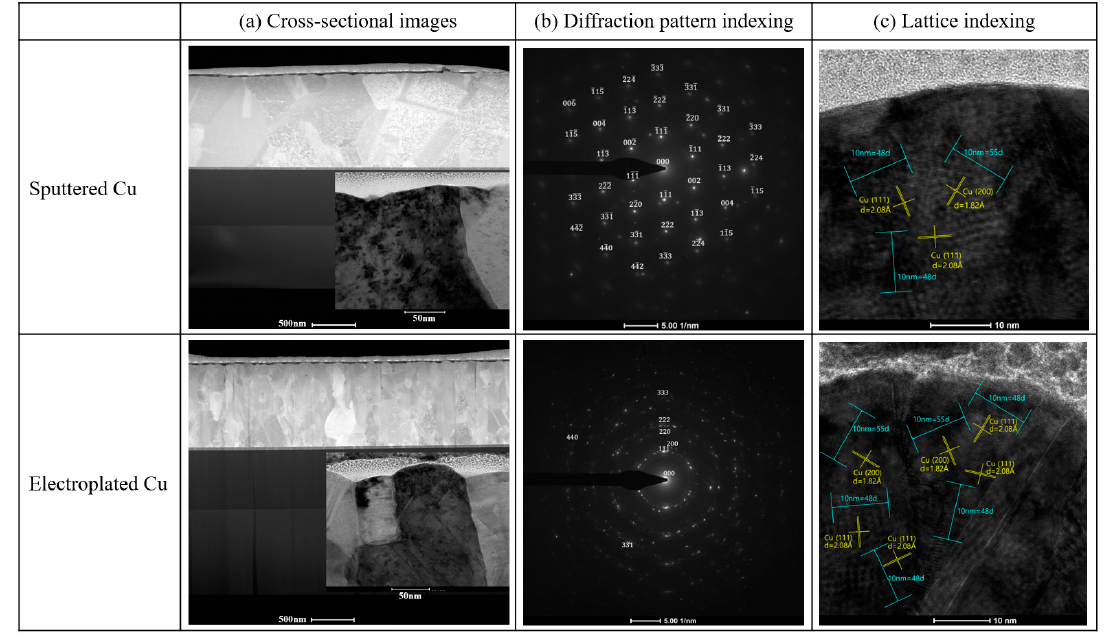
Figure 4. TEM analysis of plasma treated Cu thin films: ( a ) cross-sectional images, ( b ) diffraction pattern indexing, ( c ) lattice indexing. Appl. Sci. 2019 , 9 , x FOR PEER REVIEW